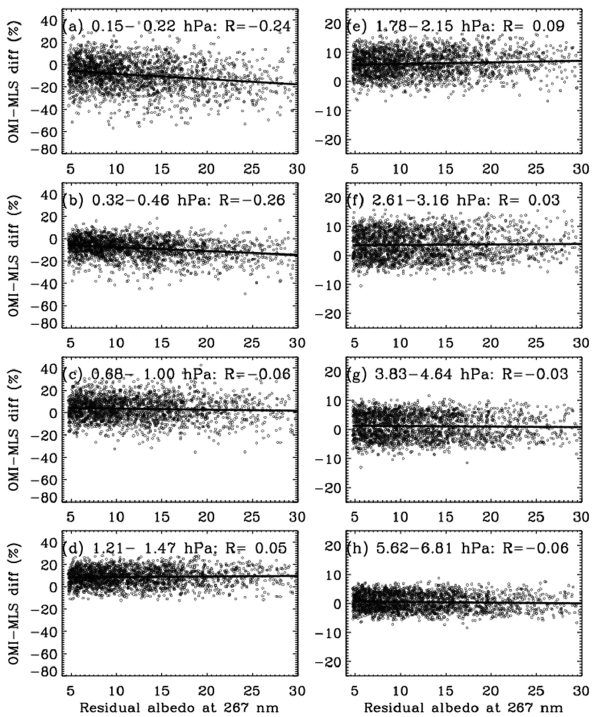
Figure 11. Same as Fig. 4 but for OMI ozone profiles simultane- ously retrieved with PMC optical